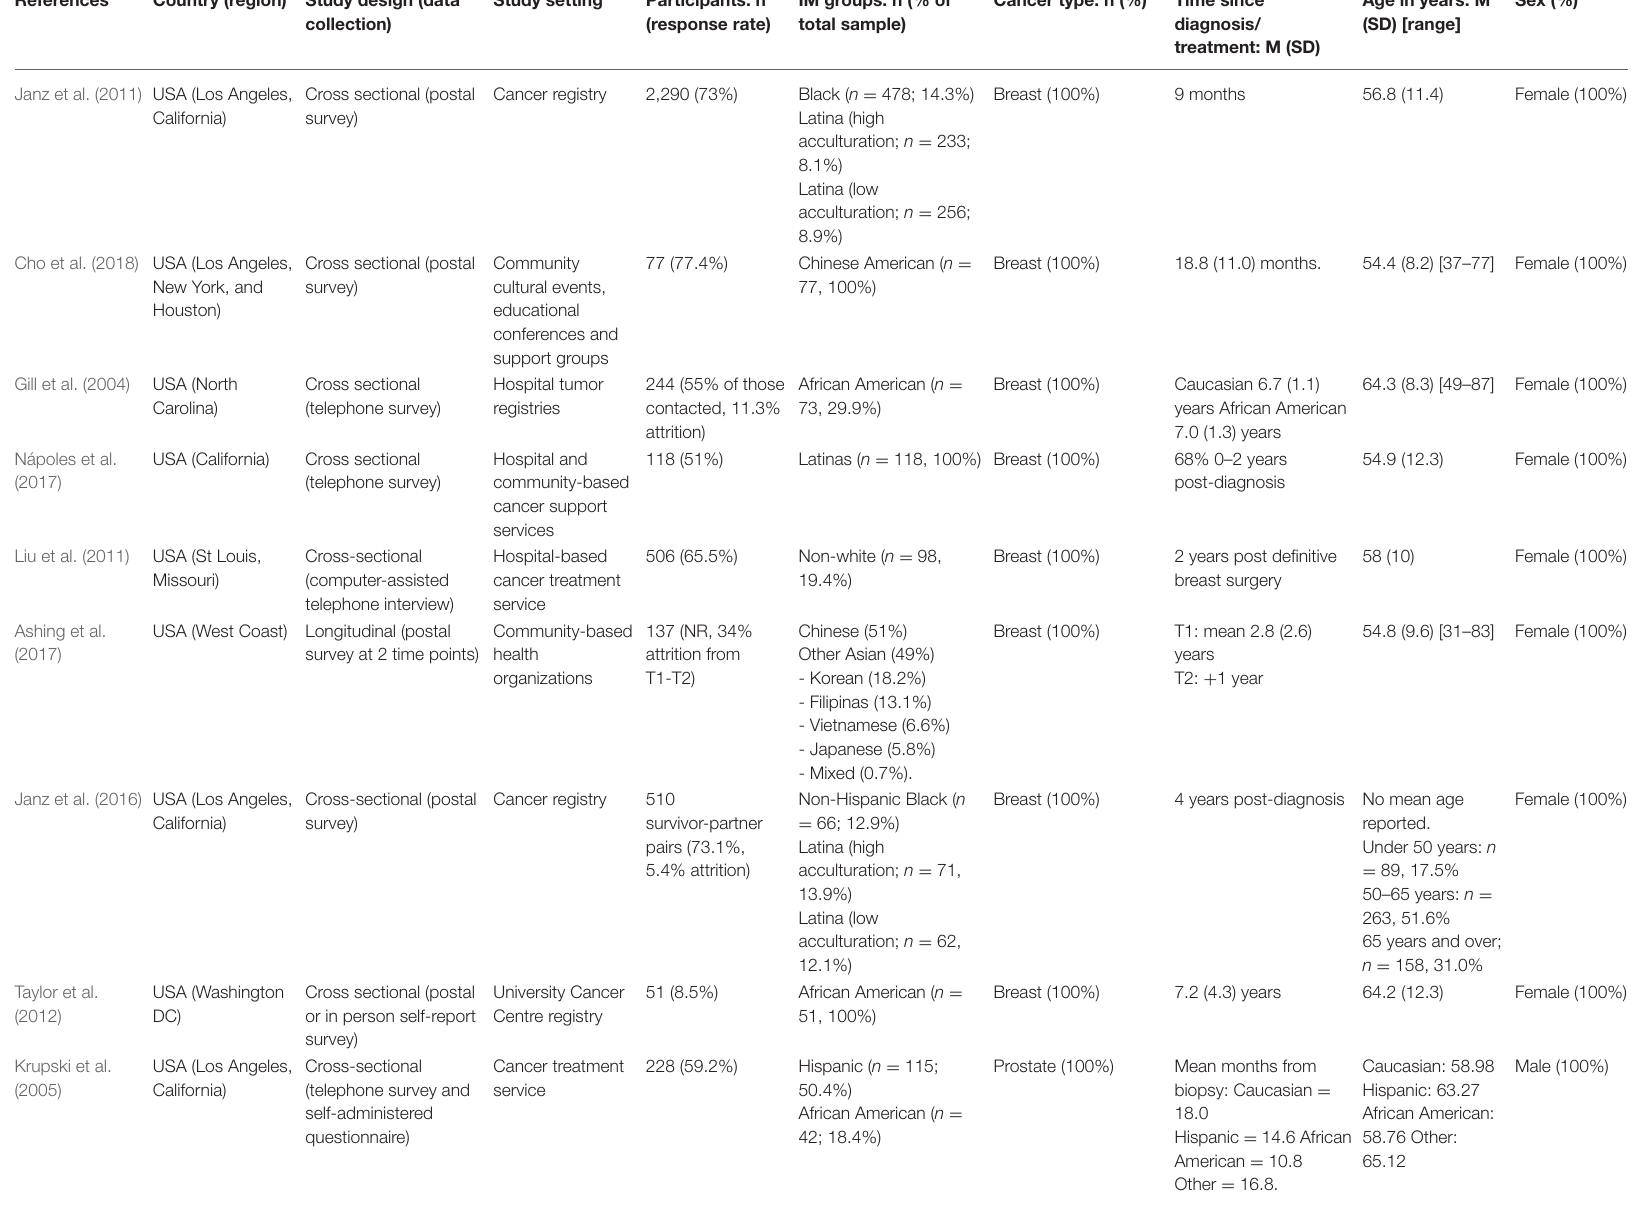
TABLE 1 | Characteristics of included quantitative